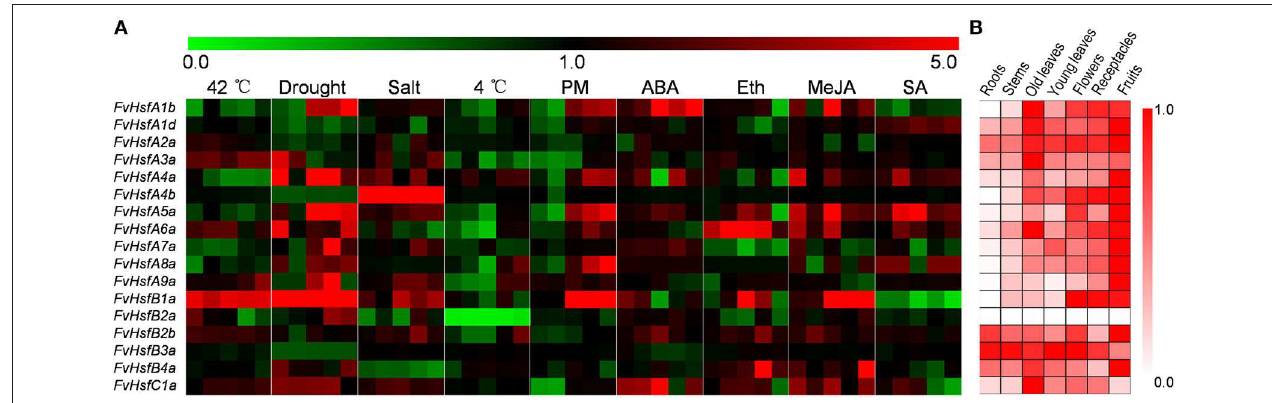
FIGURE 5 | The expression pattern of 17 FvHsf genes in different organs/tissues and under different treatments. The expression profiles were generated by semi-quantitative PCR and were visualized as heat maps. The color scale represents log2 expression values, with red denoting increased transcript abundance and green denoting decreased transcript abundance. Only partial data are shown for the stress and hormone treatments (the expression levels of 17 FvHsfs at 0.5hpt, 2hpt, 4hpt, 24hpt, and 48hpt of heat, cold, salt, and hormone treatments; the expression levels of 17 FvHsfs at 24 hpt/i, 48 hpt/i, 72 hpt/i, 144 hpt/i, and 168 hpt/i of drought treatment and powdery mildew infection). Detailed expression profiles of all 17 FvHsfs in response to all treatments are provided in Supplementary Figures S1 , S2 . (A) The expression profiles of the 17 FvHsfs in response to different treatments. (B) The organ/tissue distribution of 17 FvHsf genes under homeostatic conditions, with the red marks indicating the relative level of each FvHsf transcript in different